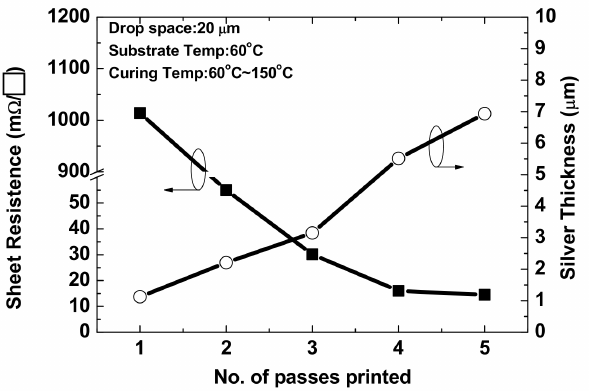
Figure 10. Sheet resistance and conductivity of silver films obtained with one to five-pass printing.